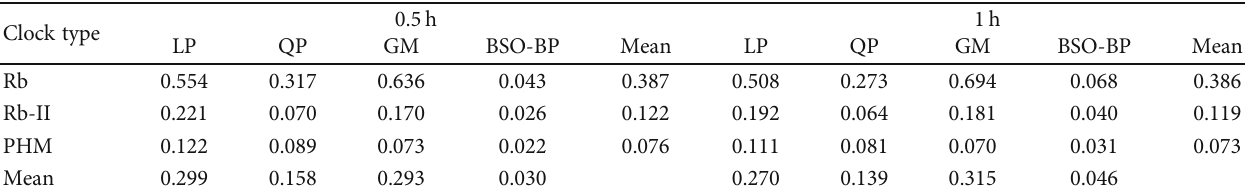
Table 3: The average prediction accuracy for 0.5 hours and 1 hour for three di ff erent types of clocks based on 12-hour SCB data. Clock